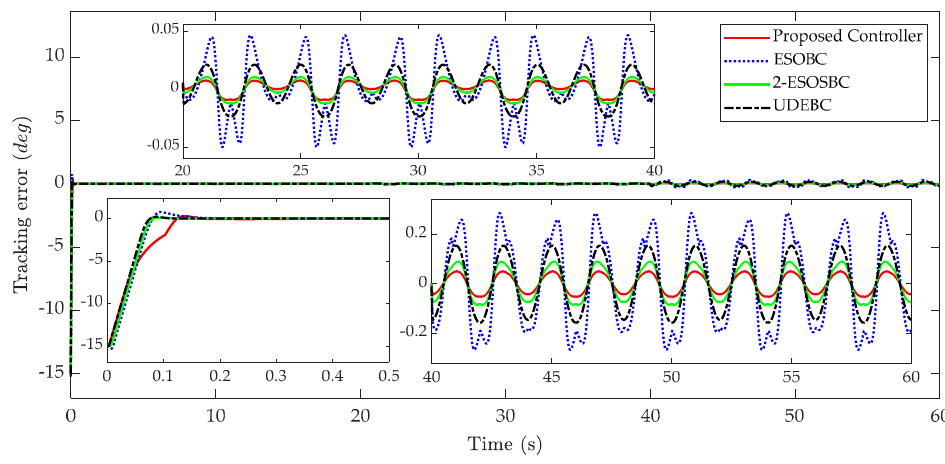
Figure 4. The tracking errors of the proposed method and other approaches in the presence of matched and mismatched disturbances.